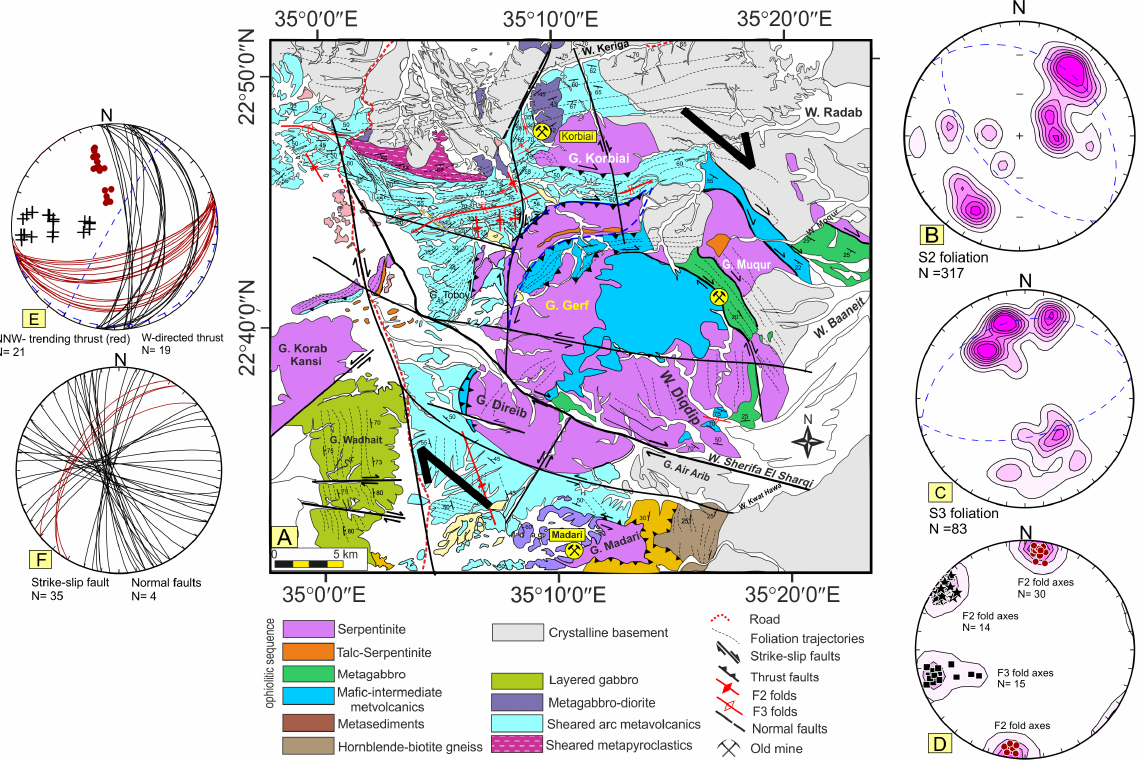
Figure 12. ( A ) Structural map of Gerf area, ( B , C ) Contoured stereonet plot of poles to S2 and S3 foliations respectively, contour interval: 0, 2, 4, 6, 8, 10, ( D ) Contoured stereonet plot of trend and plunge to F2 and F3 fold axes respectively, contour interval: 0, 3, 6, 9, 12, 15, ( E ) The red lines are the great circle plots of the NNW-directed thrusts whereas the black lines are the great circle plots of the W-directed thrusts. The black dots are poles to the E-W trending thrusts whereas the red crosses are poles to the N-S striking thrusts, ( F ) The black lines are the great circle plots of the strike slip faults whereas the red lines are the great circle plots of the normal